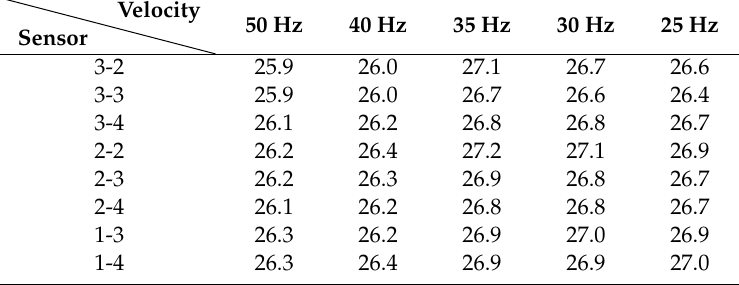
Table 9. Di ff erent supply air velocities and indoor temperatures at 0.75